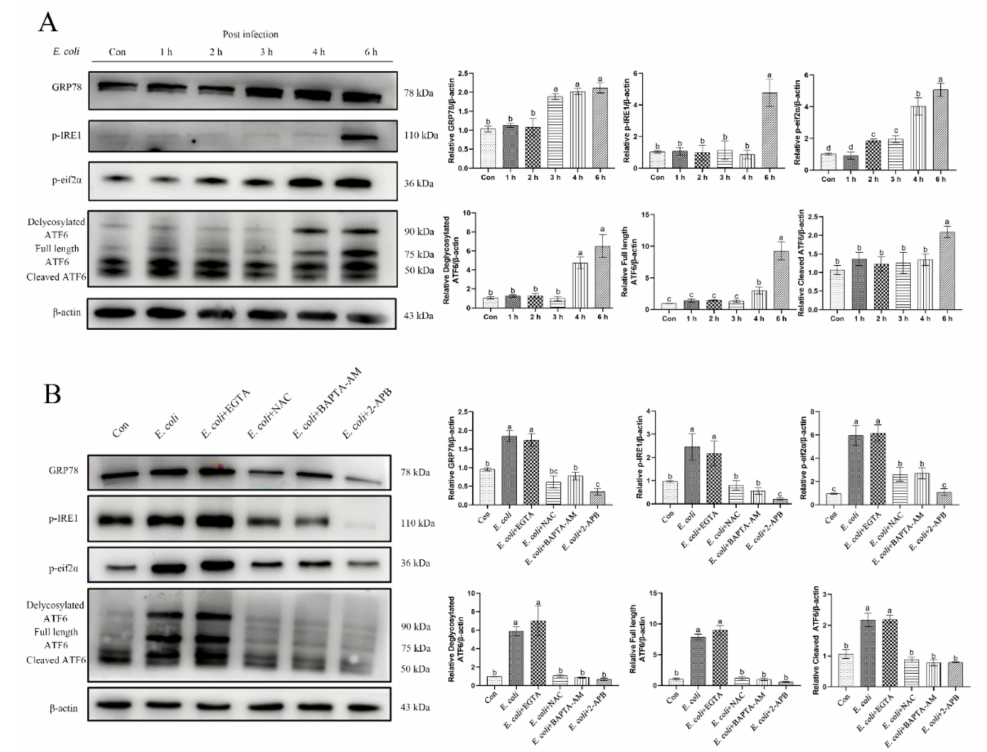
Figure 7. ERS is involved in regulating the E. coli -induced inflammatory response in bEECs. Primary bEECs were either uninfected or infected with E. coli for 6 h after pretreatment with EGTA (5 mM), NAC (8 mM), BAPTA-AM (10 µ M), or 2-APB (50 µ M). ( A ) Western blot analysis of ERS-related proteins (GRP78, p-IRE1, p-eif2 α , and ATF6) during E. coli infection for 1–6 h. ( B ) Expression of ERS-related proteins (GRP78, p-IRE1, p-eif2 α , and ATF6) measured by Western blot after 6 h of infection. The data are means ± SEM of three independent experiments. Bars with different letters indicate significant differences ( p <